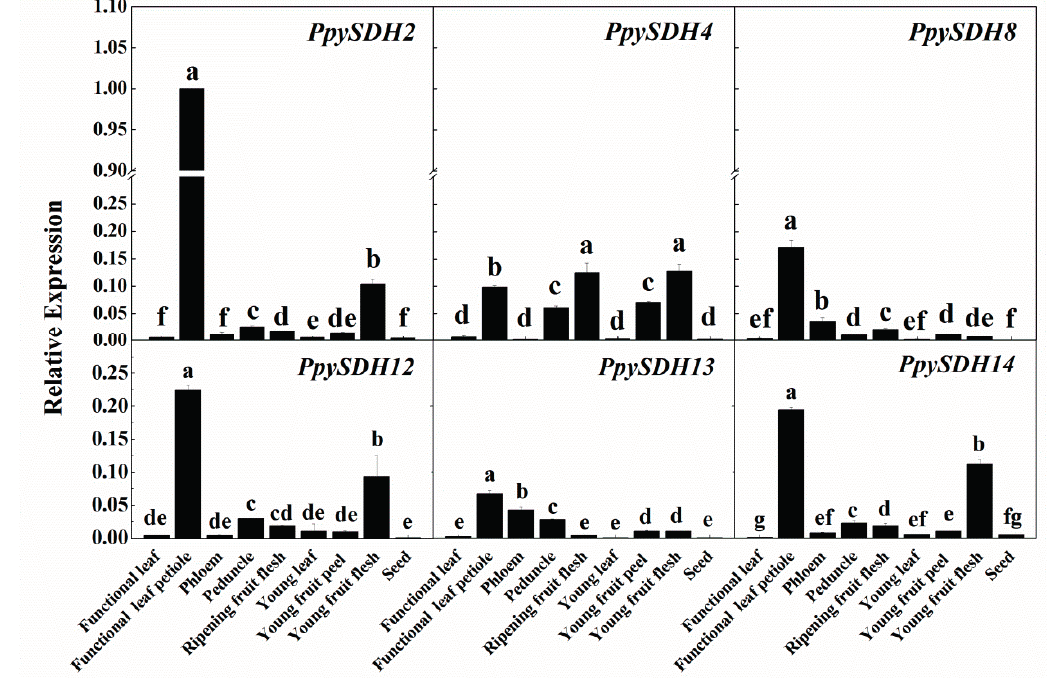
Figure 3. Relative expression levels of six selected PpySDH genes in nine tissues of sand pear ( P. pyrifolia Nakai. cv. Cuiyu). The expression of each gene was first normalized against 18S rRNA (internal control) by using the 2 −Δ C t method, and then, the strongest expression, PpySDH2 in functional leaf petiole in this figure, served as a calibrator (1.0); expression of the remaining genes was expressed as a multiple of the calibrator. Error bars indicate the standard error (SE) from three biological replicates. Different letters within each chart indicate means that are significantly different ( p ≤